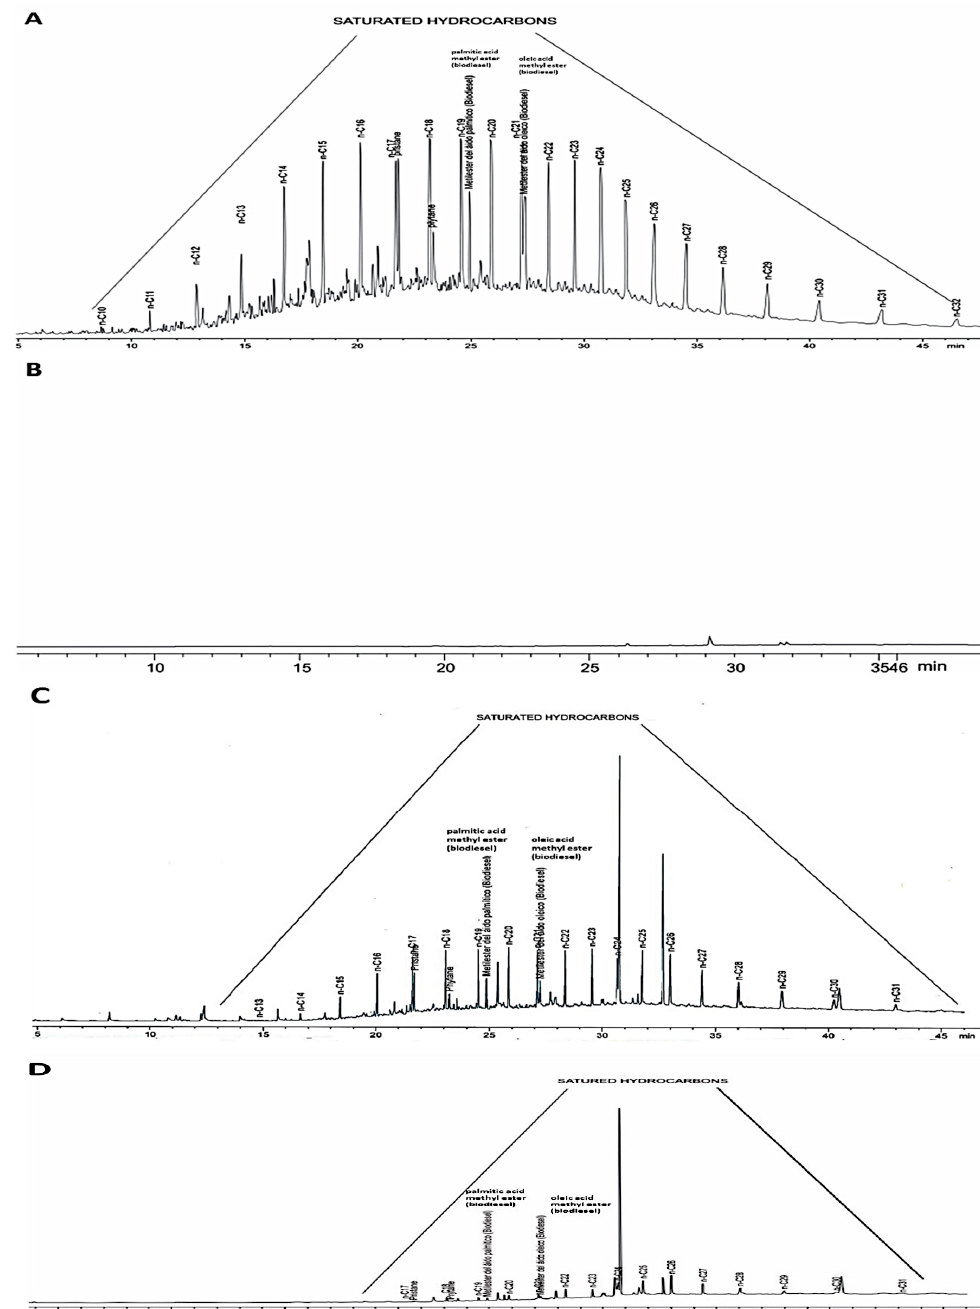
Figure 2. Gas chromatography (GC) ( A ) nondomestic wastewater (WW), ( B ) the treated wastewater (TWW) obtained through HPFD, ( C ) the TWW obtained through CLLE DCM , and ( D ) a raffinate (partially treated water) produced through CLLE DCM –HPFD of the nondomestic wastewater (WW). Markers: n-alkanes, pristine, and phytane.